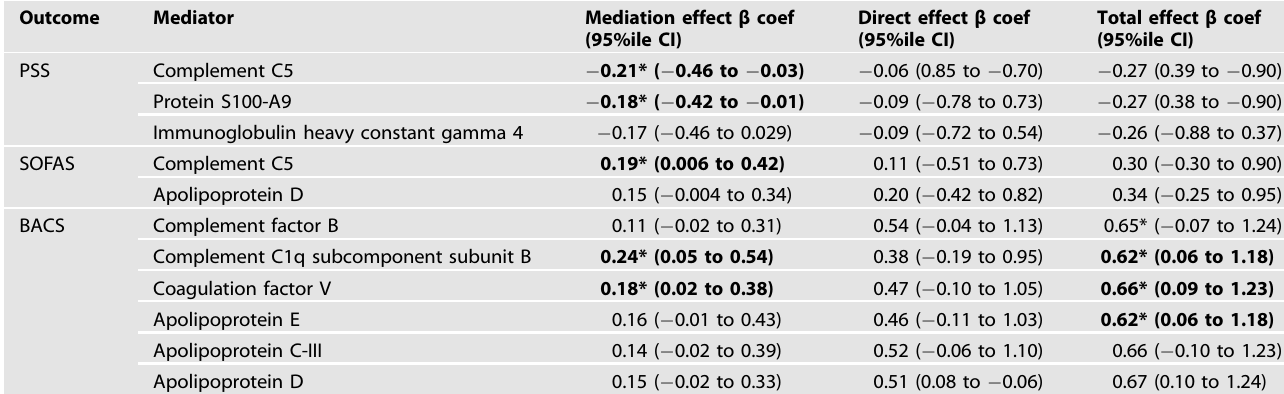
Table 4. Results of univariate mediation analysis of omega-3 fatty acid associated plasma proteins on clinical outcome at follow-up.